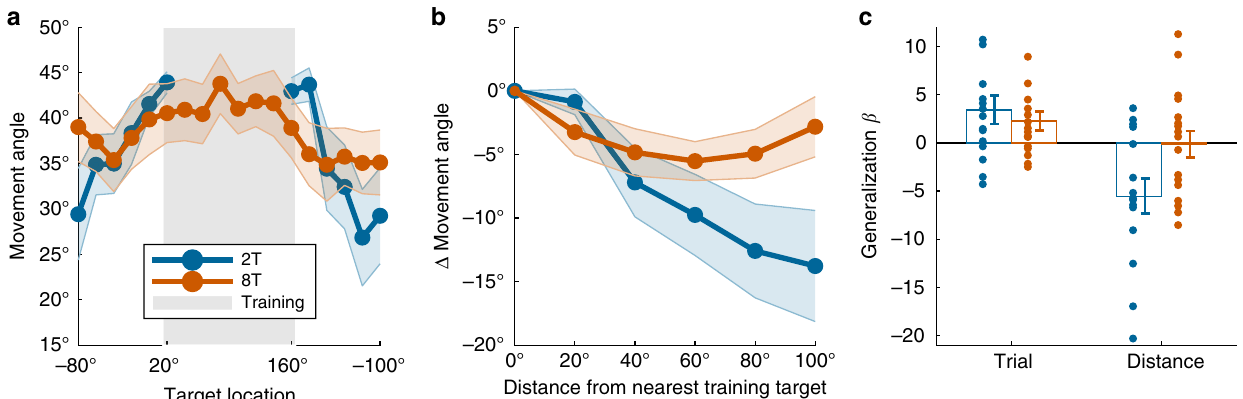
Fig. 10 Experiment 4 results. a Mean movement angles in degrees ( n = 32) in the generalization block targets and training block targets (gray shading). b Mean change in movement angle (degrees) relative to mean movement angles at the nearest training targets. c Results of regression analysis, showing effects of trial number and generalization target distance on movement angles in the generalization block. Shading and error bars represent